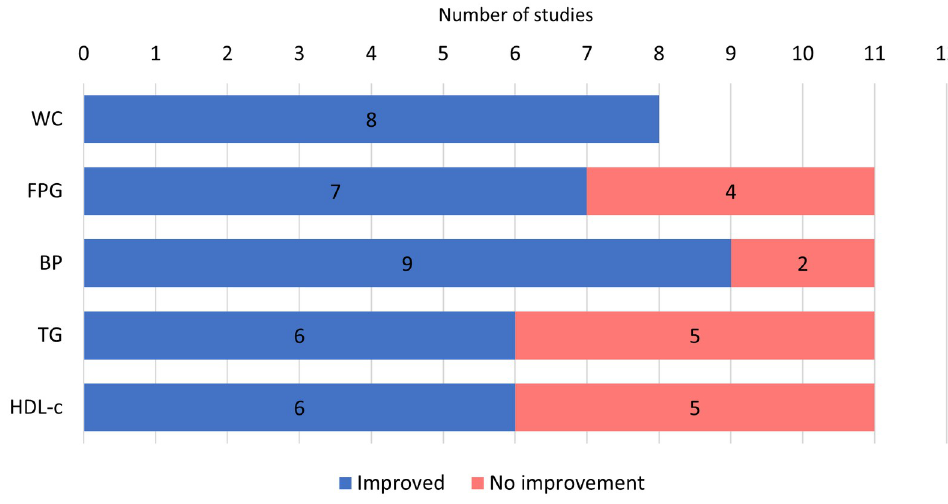
Fig 3. Outcomes for metabolic syndrome components and the proportion presenting statistically significant and non-significant results. WC = waist circumference; FBG = fasting blood glucose; BP = blood pressure; TG = triglyceride; HDL-c = high-density lipoprotein cholesterol.